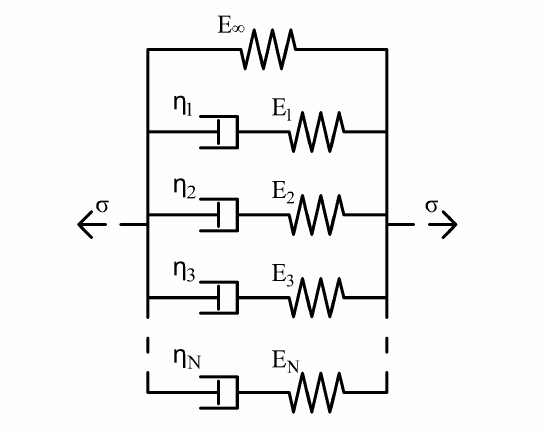
Figure 2. Reological model of the Maxwell chain.